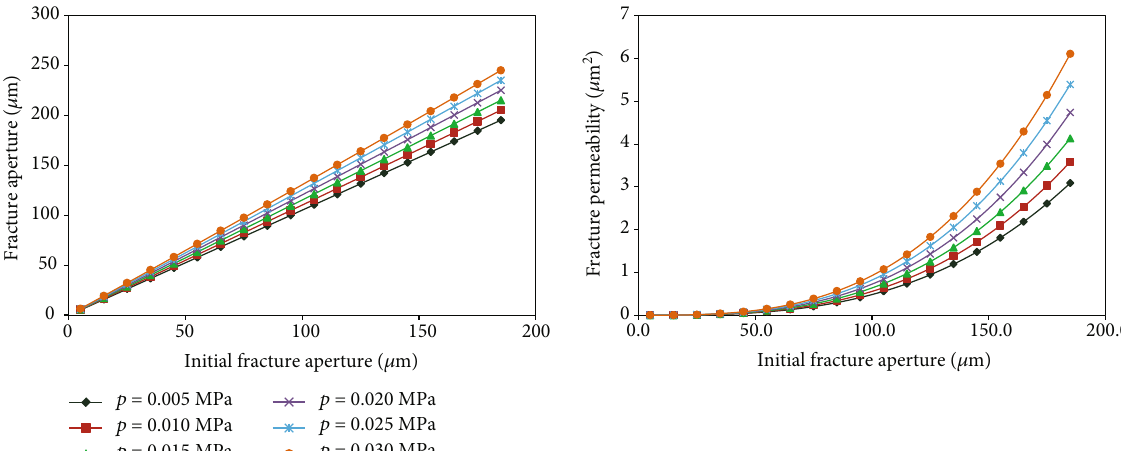
Figure 12: Fracture aperture and fracture permeability vs. initial fracture aperture.